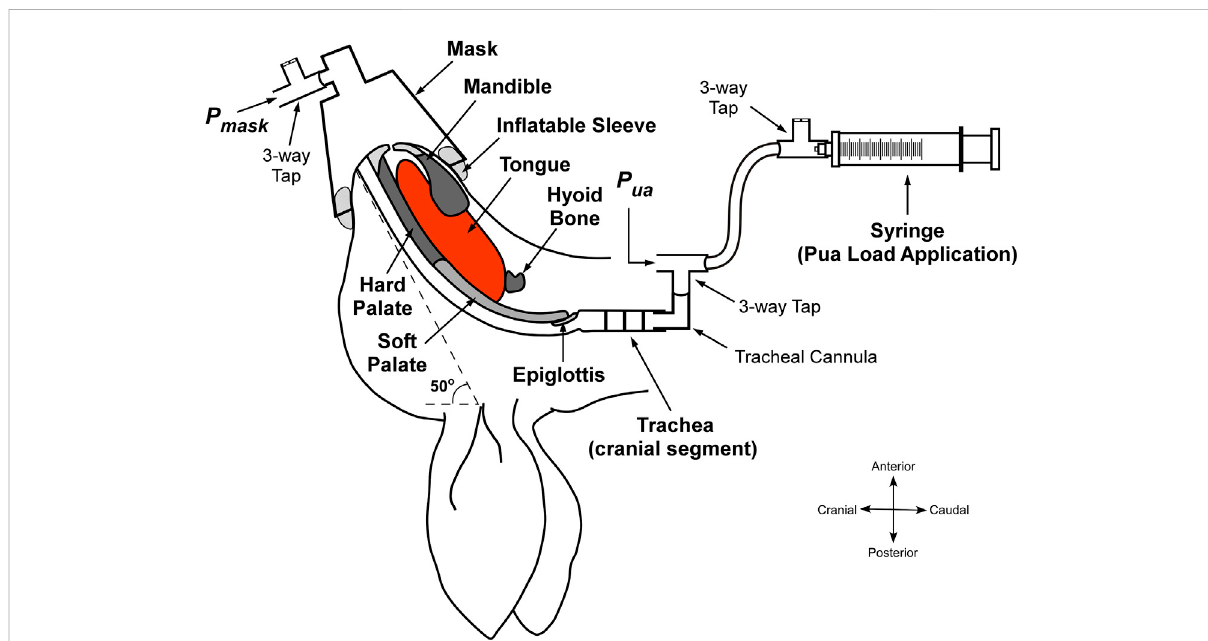
FIGURE 1 Schematicof the experimental setup with upper airwaynegative pressure application. The upper airway was isolated atthe level of thetrachea. A syringe is connected to the cranial tracheal segment and pulled to create a negative pressure in the upper airway, which is detected at the level of the mask. Pmask, mask pressure. Pua, pressure at the cranial end of the trachea. Adapted and modi fi ed from Amatoury, 2012 (Amatoury, 2012).